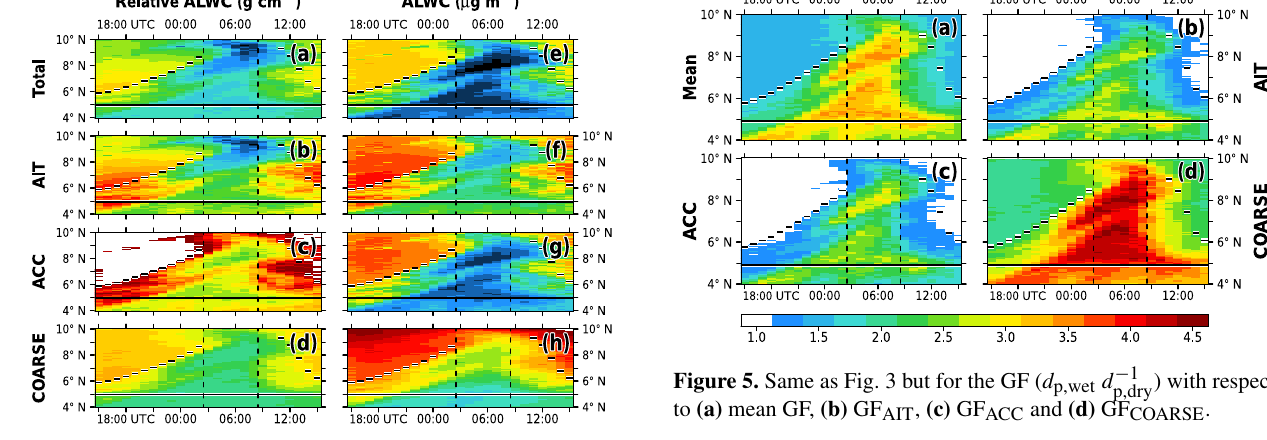
Figure 4. Same as Fig. 3 but for (left) relative ALWC (gALWCcm − 3 dry aerosol) with respect to (a) total relative ALWC, (b) relative ALWC AIT , (c) relative ALWC ACC and (d) rel- ative ALWC COARSE ; (right) absolute ALWC (µgALWCm − 3 air) with respect to (e) total ALWC, (f) ALWC AIT , (g) ALWC ACC and (h) ALWC COARSE .